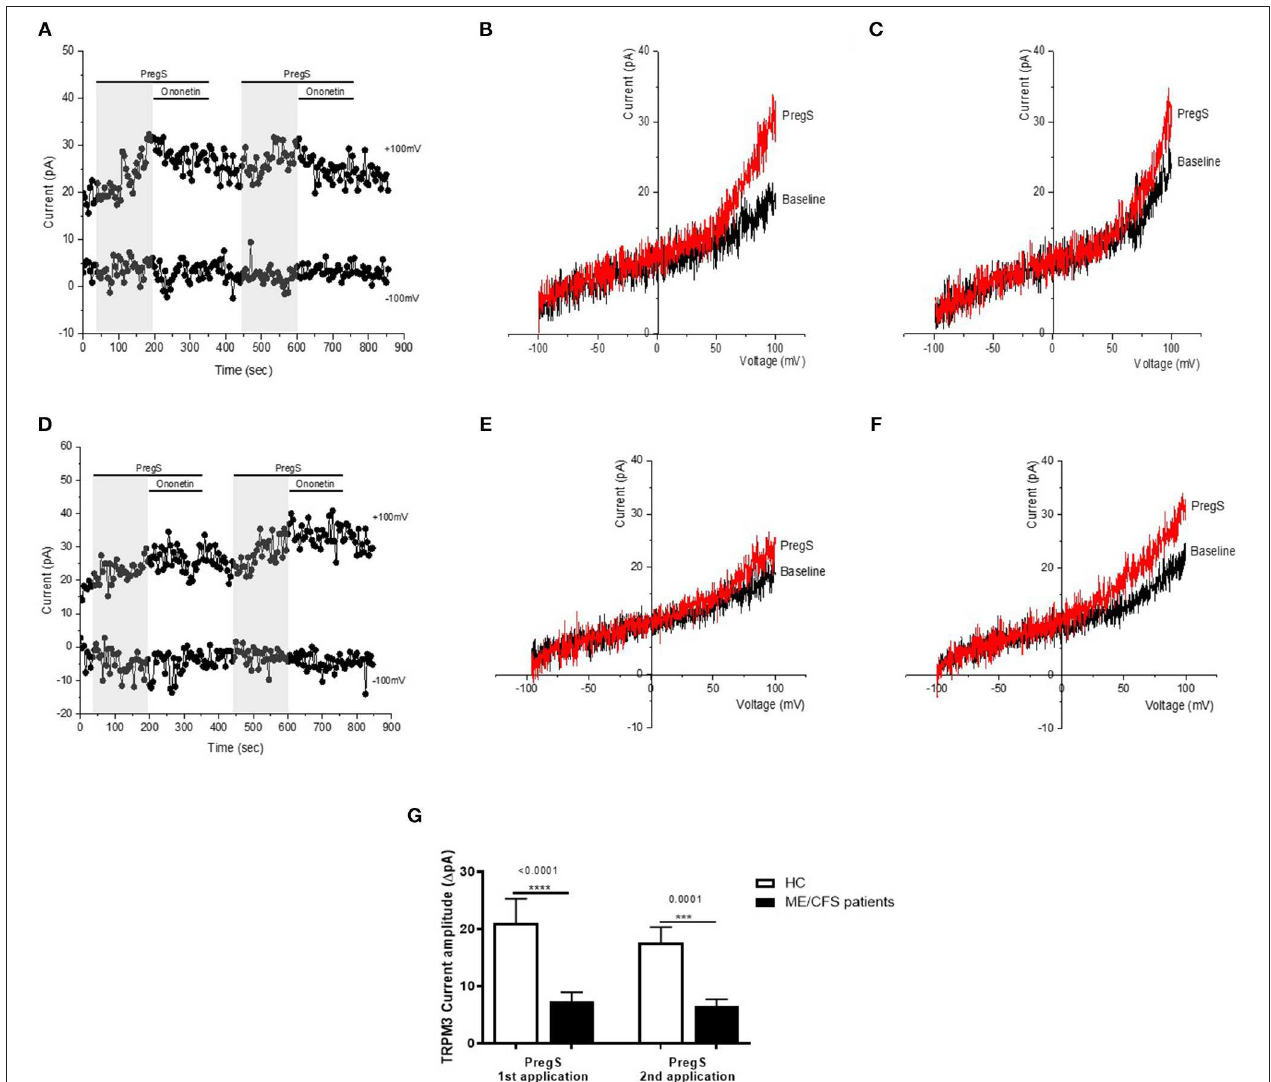
FIGURE 2 | TRPM3 activity after successive applications of PregS. Data were obtained under whole-cell patch clamp conditions. (A) A representative time-series of current amplitude at + 100mV and − 100mV showing the effect of successive applications of 100 µ M PregS (gray) on ionic currents in IL-2 stimulated NK cells from HC. (B) I – V before and after the first PregS stimulation in a cell corresponding with (A). (C) I – V before and after the second PregS stimulation in a cell corresponding with (A). (D) A representative time-series of current amplitude at + 100mV and − 100mV showing the effect of successive applications of 100 µ M PregS (gray) on ionic currents in IL-2 stimulated NK cells from ME/CFS patients. (E) I – V before and after the first PregS stimulation in a cell as shown in (D). (F) I – V before and after the second PregS stimulation in a cell as shown in (D). (G) Bar graphs representing TRPM3 current amplitude at + 100mV after successive applications of 100 µ M PregS in ME/CFS patients ( N = 8 ; n = 27 and n = 25) compared with HC ( N = 8; n = 31 and n = 29). Data are represented as mean ± SEM. ME/CFS, myalgic encephalomyelitis/chronic fatigue syndrome; HC, healthy controls; NK, natural killer; PregS, Pregnenolone sulfate; TRPM3, Transient Receptor Potential Melastatin 3. *** p = 0.0001, **** p <